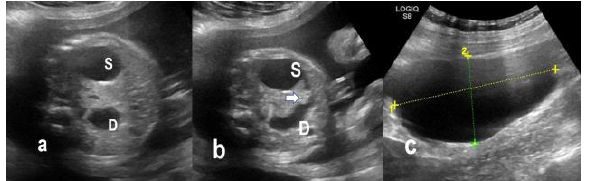
Figure 1: a) Antenatal Ultrasonography at 28 weeks 4 days showing dilated stomach (S) and duodenum (D) giving the Double-bubble sign. b) Hyperechoic band around duodenum (arrow). c) Showing the maternal right ovarian cyst.